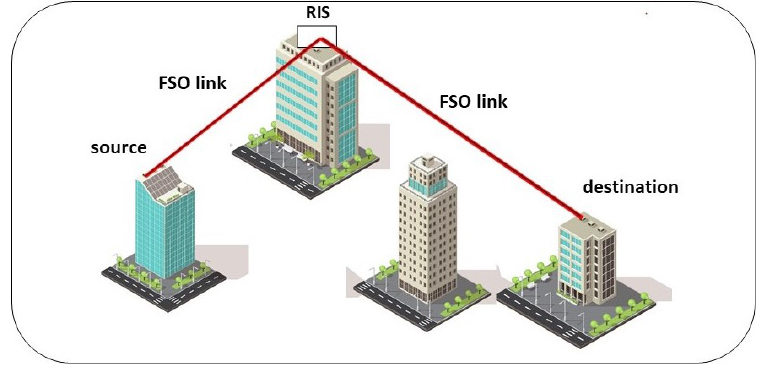
Figure 1. Simplified block scheme of FSO RIS-ACs